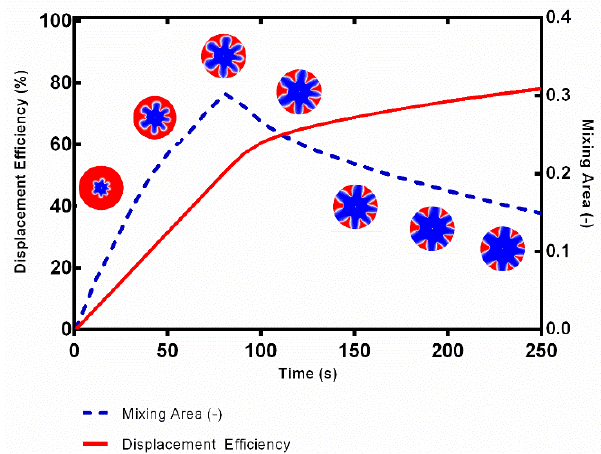
Figure 7. Temporal evolution of fingering for Ruyer-Quil’s model with displacement efficiency and mixing area for Re = 2.2 × 10 − 3 , Pe = 1.45 and R = 2.